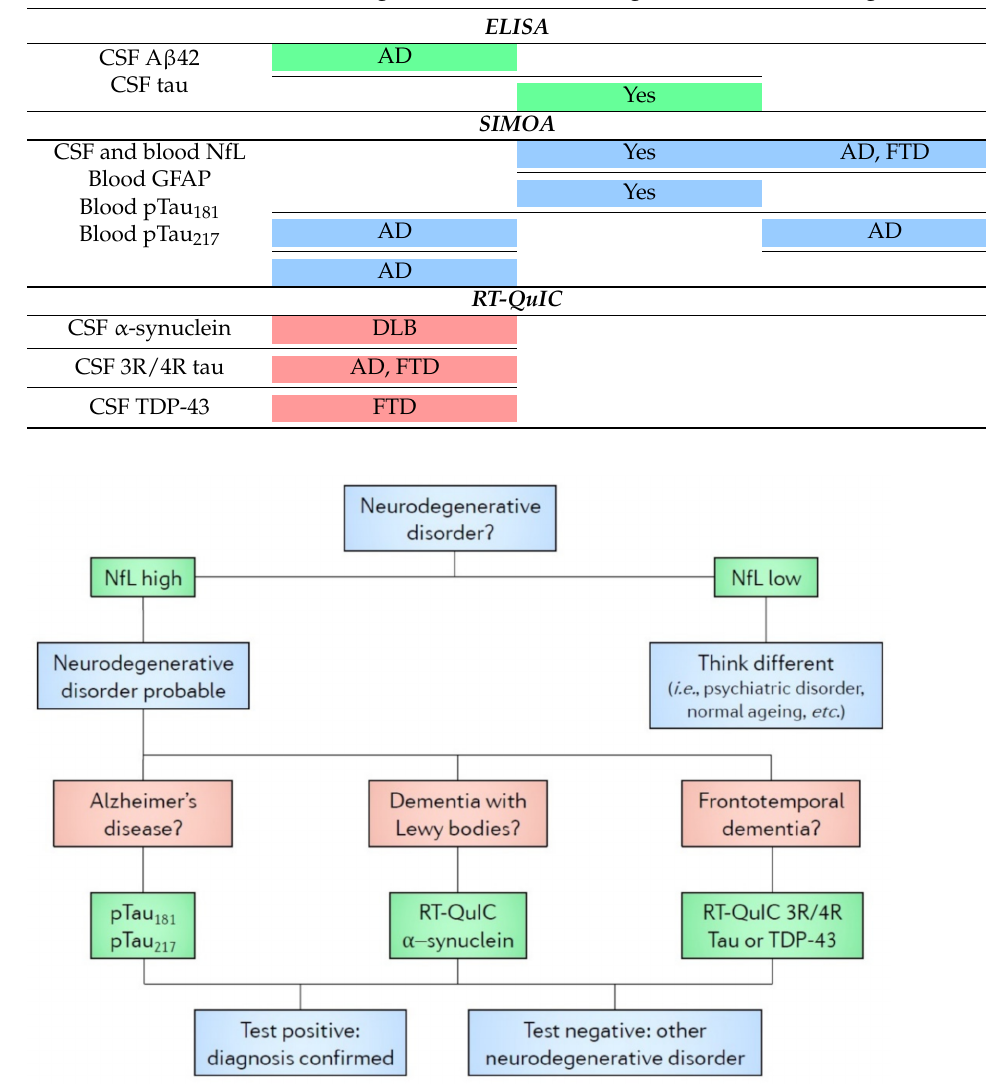
Figure 2. A proposed algorithm for diagnostics and prognostic assessment of neurodegenerative dementias. AD, Alzheimer’s disease; CSF, cerebrospinal fluid; DLB, dementia with Lewy bodies; FTD, frontotemporal dementia; NfL, neurofilament light chain; pTau181, tau phosphorylated at threonine 181; pTau217, tau phosphorylated at threonine 217; RT-QuIC, real-time quaking-induced conversion; TDP-43, TAR DNA-binding protein